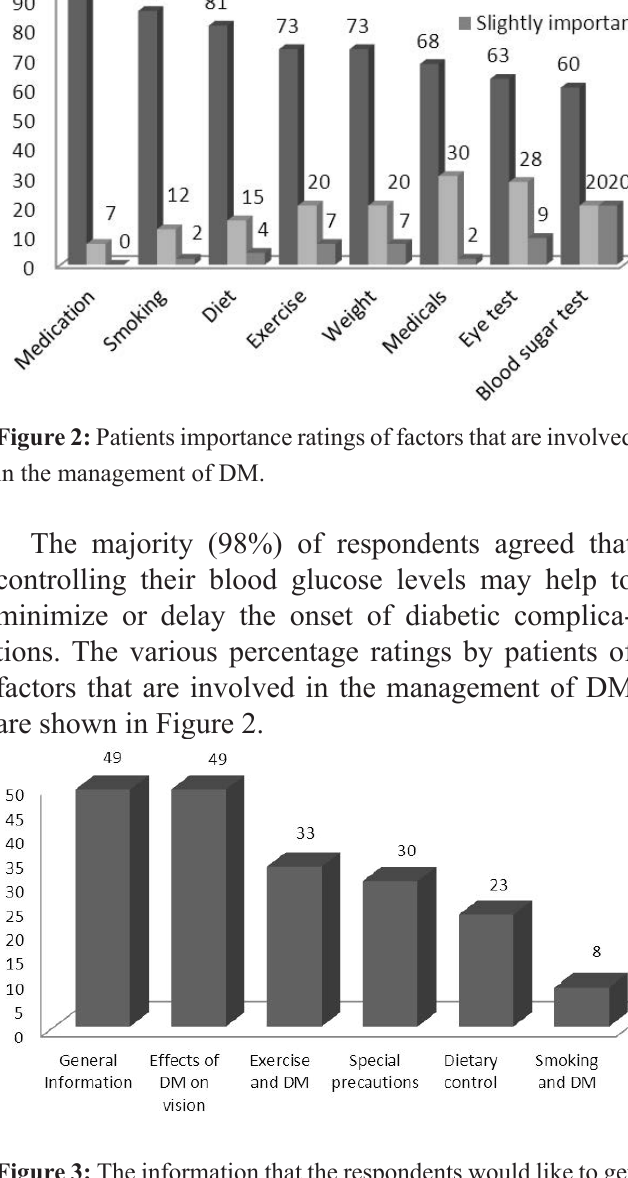
Figure 3: The information that the respondents would like to get from clinicians about diabetes.